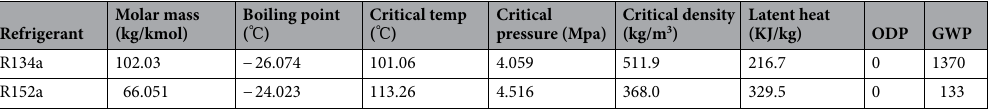
Table 3. The characteristics of refrigerants.